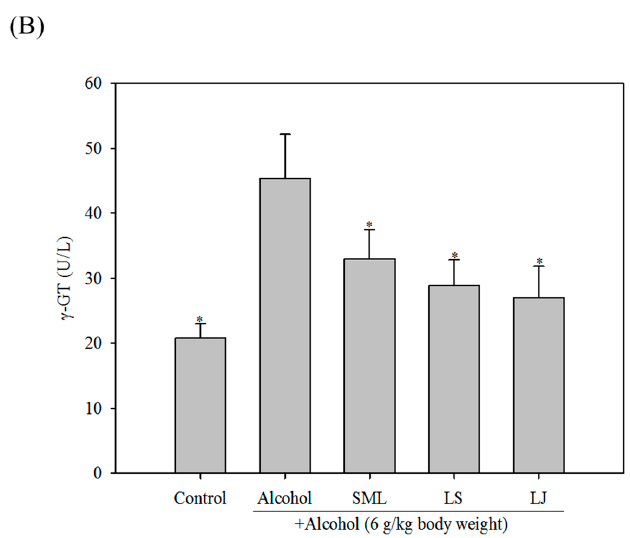
Figure 3. Effects of heat-killed Lactobacillus salivarius (LS), Lactobacillus johnsonii (LJ) and silymarin (SML) on serum aspartate transaminase (AST) and alanine transaminase (ALT; A ); and γ -glutamyl transferase ( γ -GT; B ) levels in rats induced by alcohol. Experimental conditions were as described in the Materials and Methods. Bars represent mean ± SD ( n ≥ 9). * p < 0.05 or # p < 0.05 for any alcohol treatment groups and control group versus alcohol group.